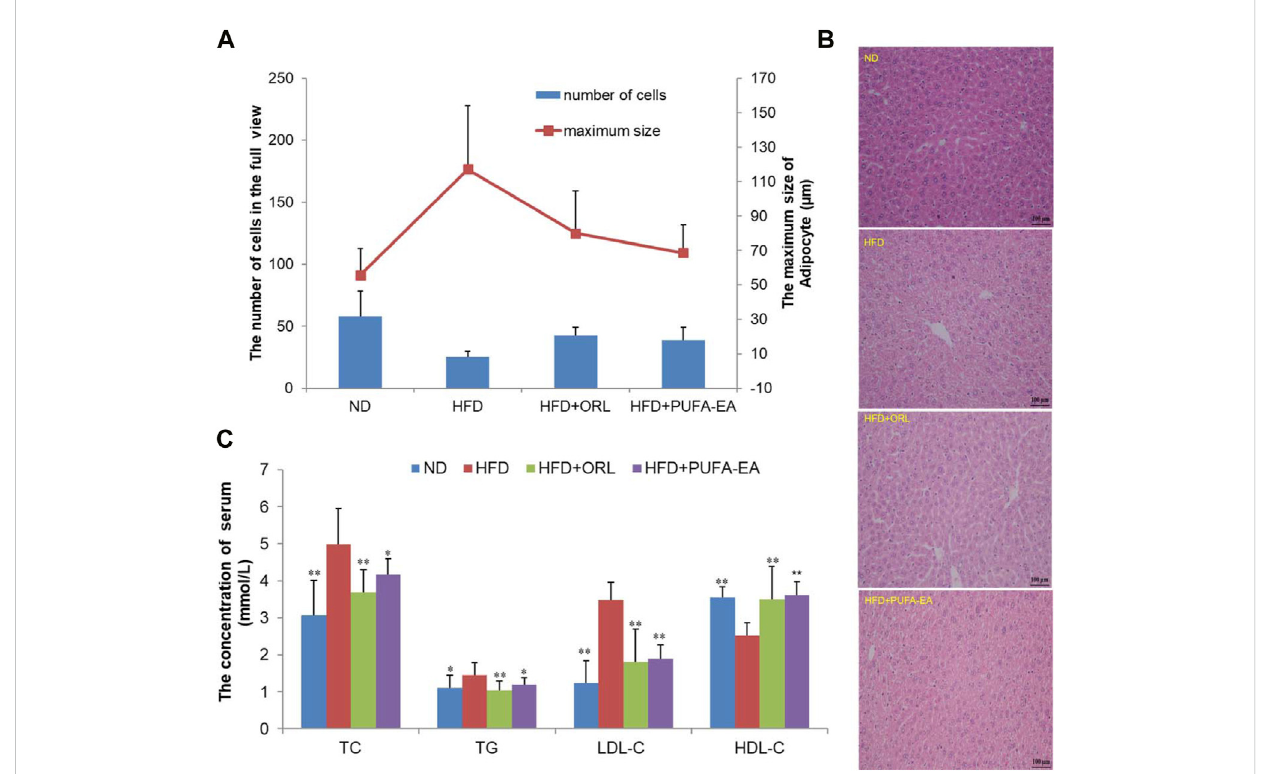
FIGURE 10 The PUFA-EA mixture showed in vivo anti-obesity effects in HFD mouse models. (A) The maximum size of adipocyte and the number of cells of the experimental mice ’ s liver tissue in the full view captured with the microscope (200×). All data in the fi gure are shown as mean ± SD. Bars represent the standard deviation from duplicate determinations. (B) H&E staining of the liver after PUFA-EA supplementation. (C) Effects of PUFA-EA on plasma biochemical indicators (TC, TG, HDL-C, and LDL-C) in different groups at the end of 6-week feeding (n = 10). All data in the fi gure are shown as mean ± SD. Bars represent the standard deviation from duplicate determinations. * p < 0.05 and ** p < 0.01.